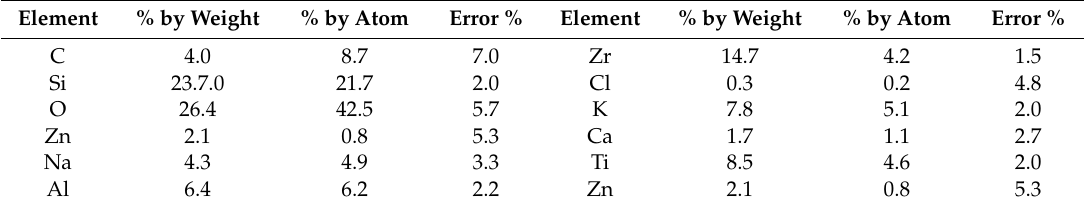
Table 3. Element spectrum determined by energy-dispersive X-ray spectroscopy (EDX).